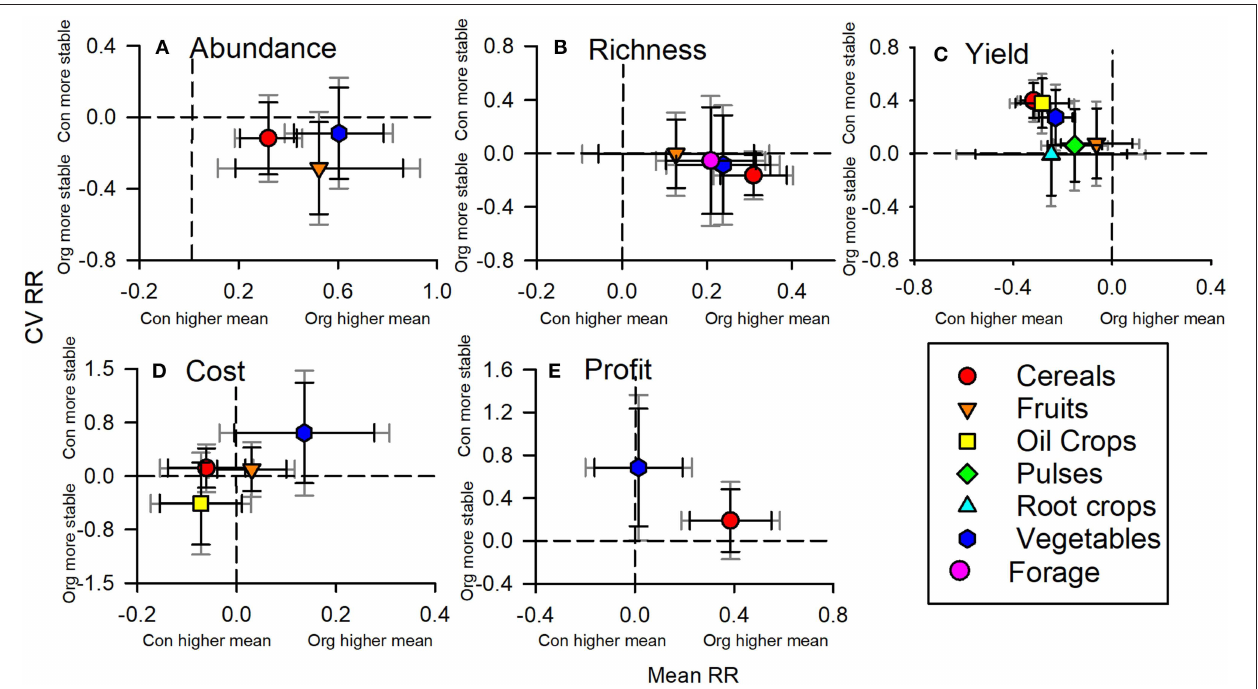
FIGURE 6 | Mean response ratio ( ± 90% CI black; 95% CI gray) vs. coefficient of variation response ratio ( ± 90% CI black; 95% CI gray) for seven FAO crop types (cereals = red, fruits = orange, oil crops = yellow, pulses = green, root crops = teal, vegetables = blue, and forage crops = pink) for (A) biotic abundance, (B) biotic richness, (C) crop yield, (D) total production costs, and (E)